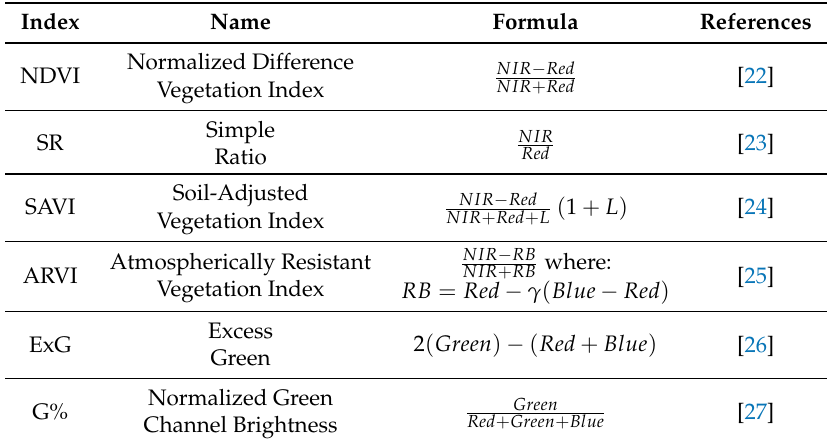
Table 4. Vegetation Indices (VIs) used in this